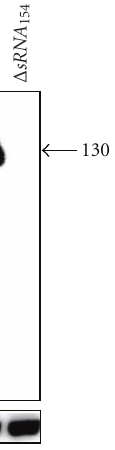
Figure 3: Northern blot analysis of M. mazei Δ sRNA 154 strain. Total RNA was purified from the respective M. mazei strains ( Δ sRNA 154 , Δ hpt, and wild type) all grown under nitrogen limiting conditions. 10 μ g of each RNA were separated by a denaturing 6%PA gel and subsequently analyzed by Northern blot using a 32 P-ATP-labelled oligonucleotide homologous to sRNA 154 . For each sample, the abundance of 5S rRNA was determined to exclude variations in RNA